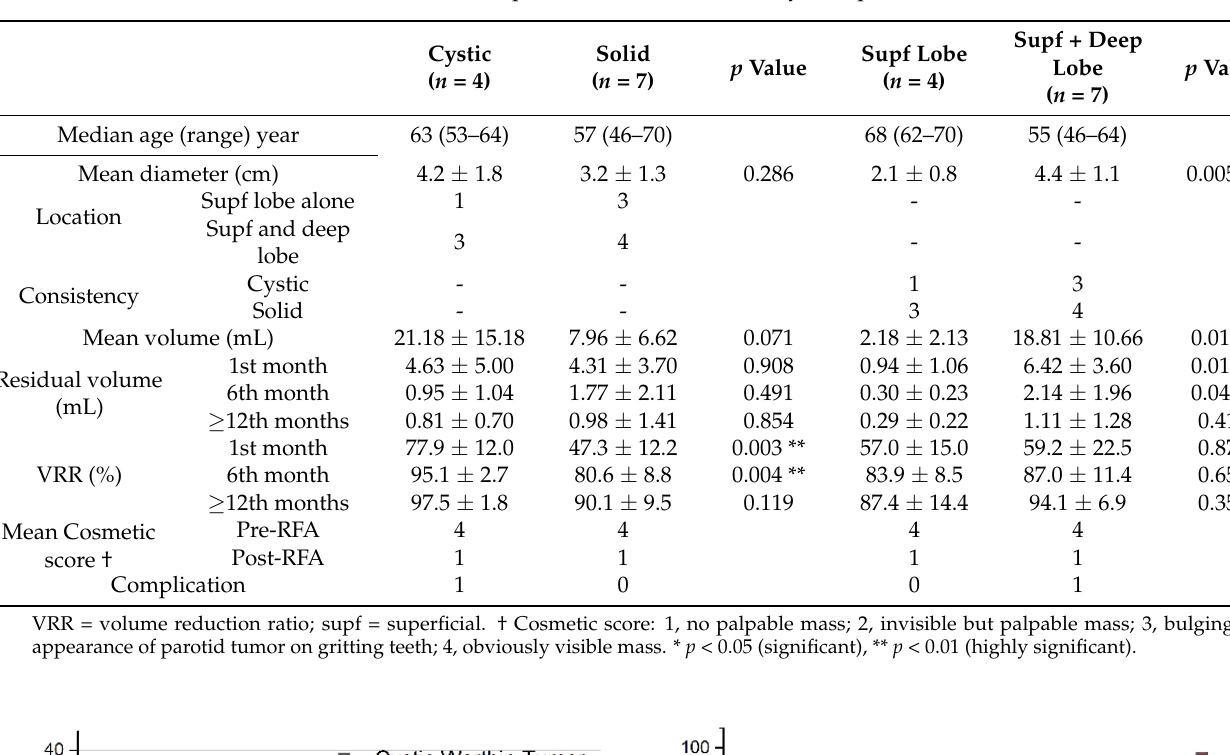
Table 2. Comparison of Warthin Tumor by Groups.